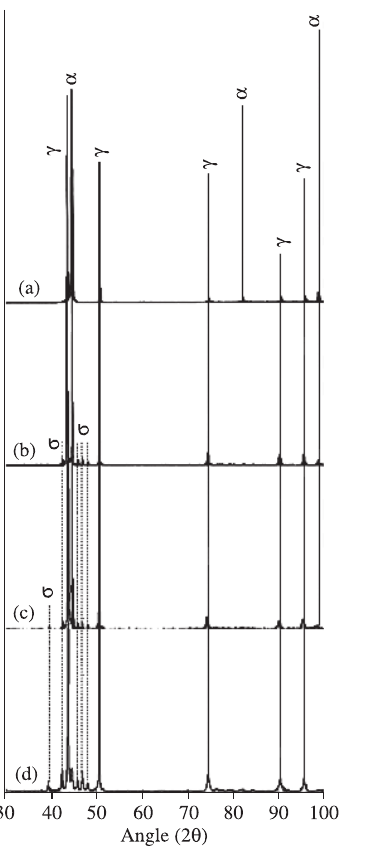
Figure 2. Examples of X-Ray diffraction patterns found in this study: a) solution-treated; b) aged 10 minutes at 850 °C; c) aged 1 hour at 850 °C; d) aged 100 hours at 850 °C. Ferrite, austenite and sigma characteristic peaks are represented by α , γ and σ respectively.